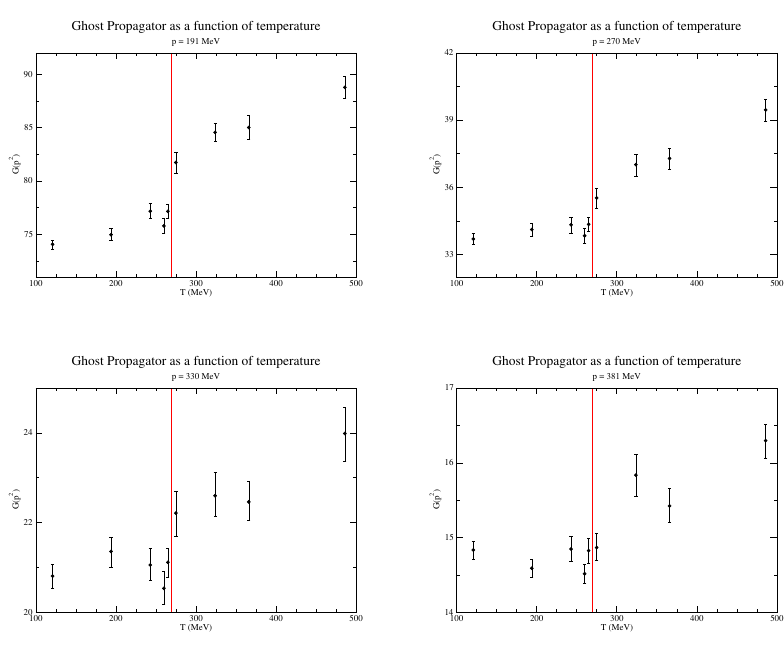
Figure 3. Ghost propagator as a function of temperature for p = 191 MeV (top left panel), p = 270 MeV (top right panel), p = 330 MeV (left bottom panel) and p = 381 MeV (right bottom panel). The red vertical line indicates the critical temperature T c .